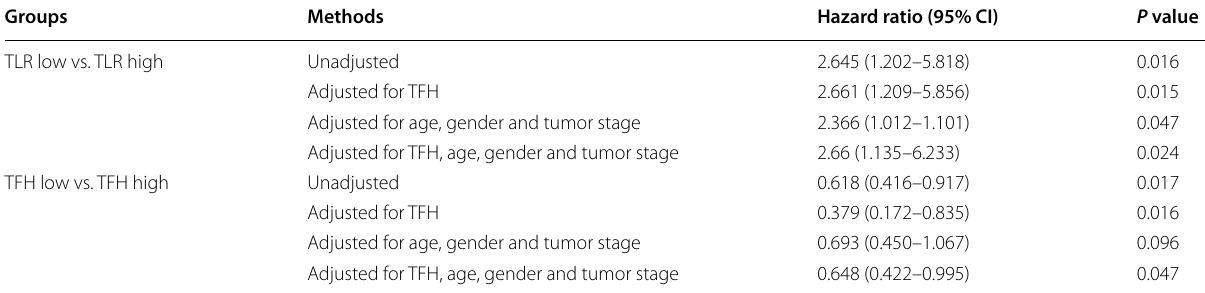
Table 5 Multivariate Cox regression analysis for overall survival